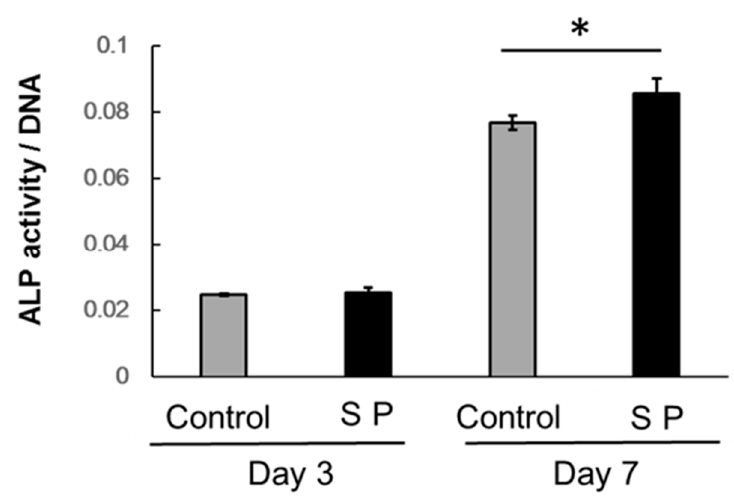
Figure 3. Effect of SP on alkaline phosphatase (ALP) activity. Confluent cells were treated with differentiation medium for 7 days (*, p > 0.05), and changes in ALP activity were investigated at days 3 and 7.